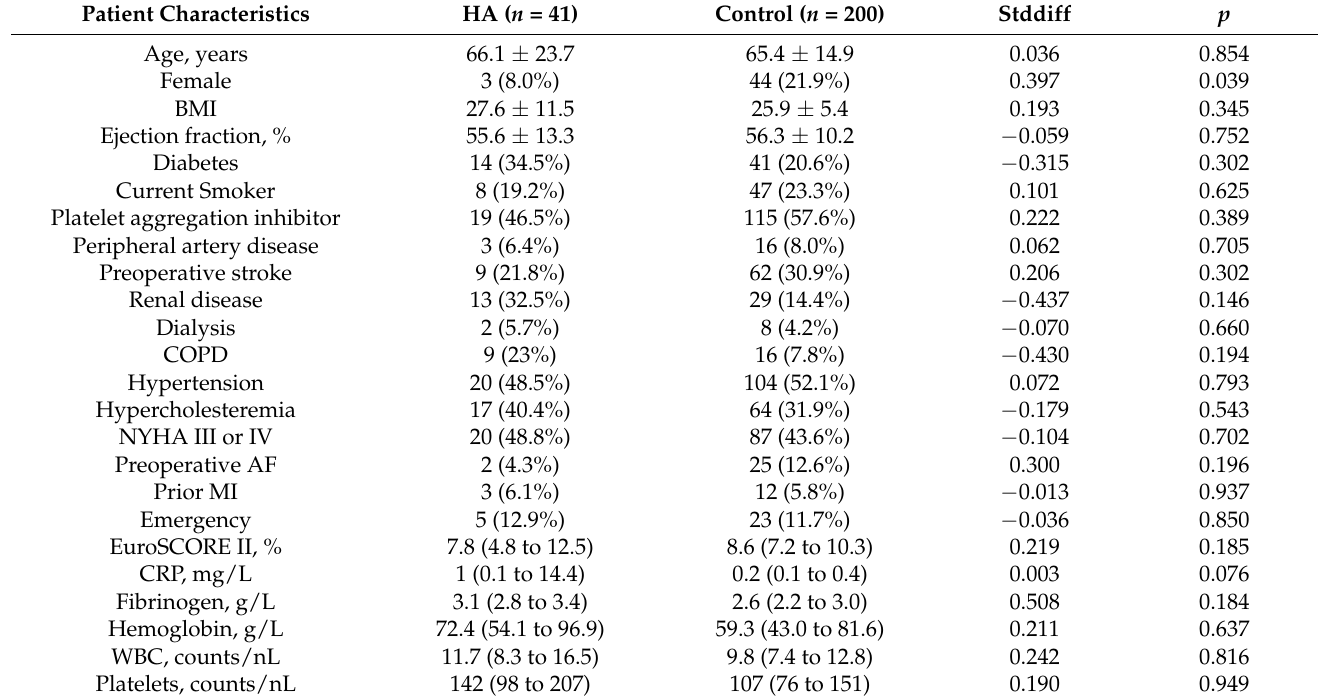
Table 1. Patient characteristics after inverse probability of treatment weighting